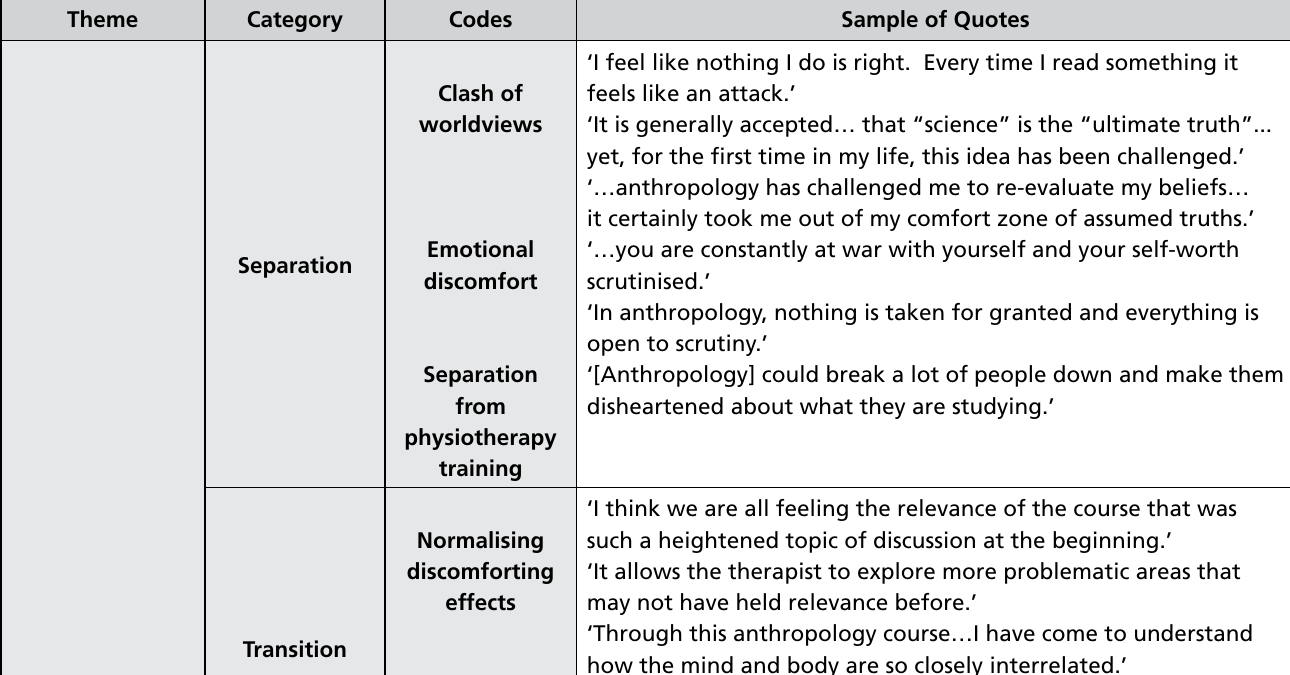
table 2: three categories for student transformation theme category codes sample of